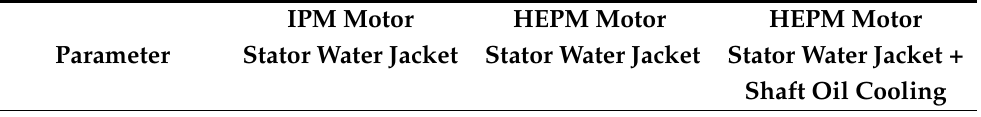
Table 8. Comparison of the thermal performance of the IPM and HEPM motors with the same stator